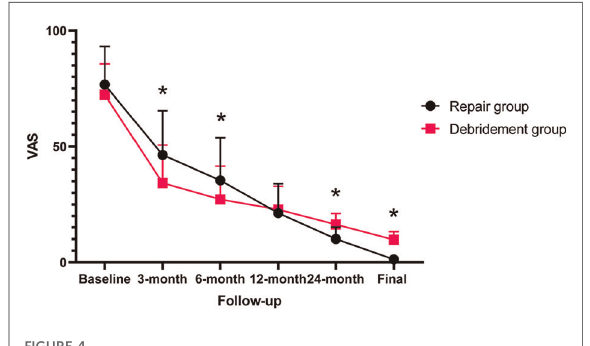
FIGURE 4 Postoperative VAS scores of the two subgroups at different follow- up time.